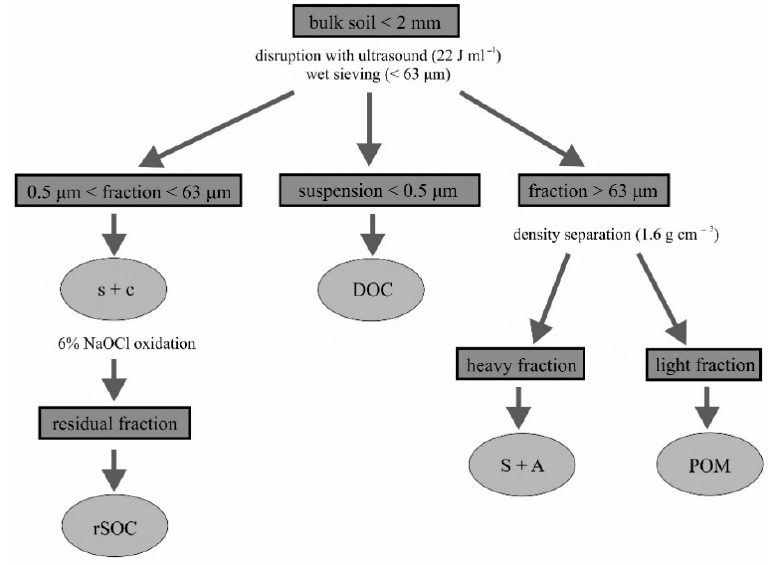
Figure 1. Schematic diagram of the fractionation procedure applied after Zimmermann et al. [21]. POM = particulate organic matter; S + A = sand and stable aggregate fraction; DOC = dissolved organic carbon; s + c = silt- plus clay-sized fraction; rSOC = chemically resistant SOC